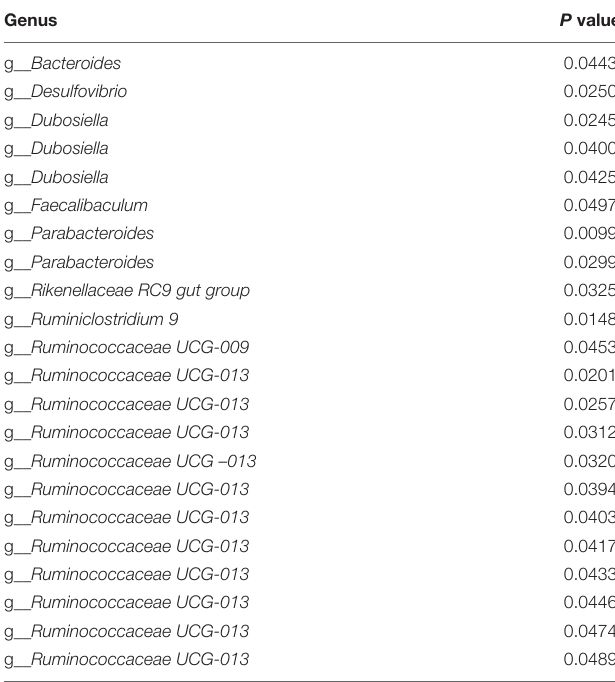
TABLE 5 | Linear mixed-effects modeling identified bacterial genera which were altered by hBD-2 in both cohorts adjusted for cohort-specific differences.